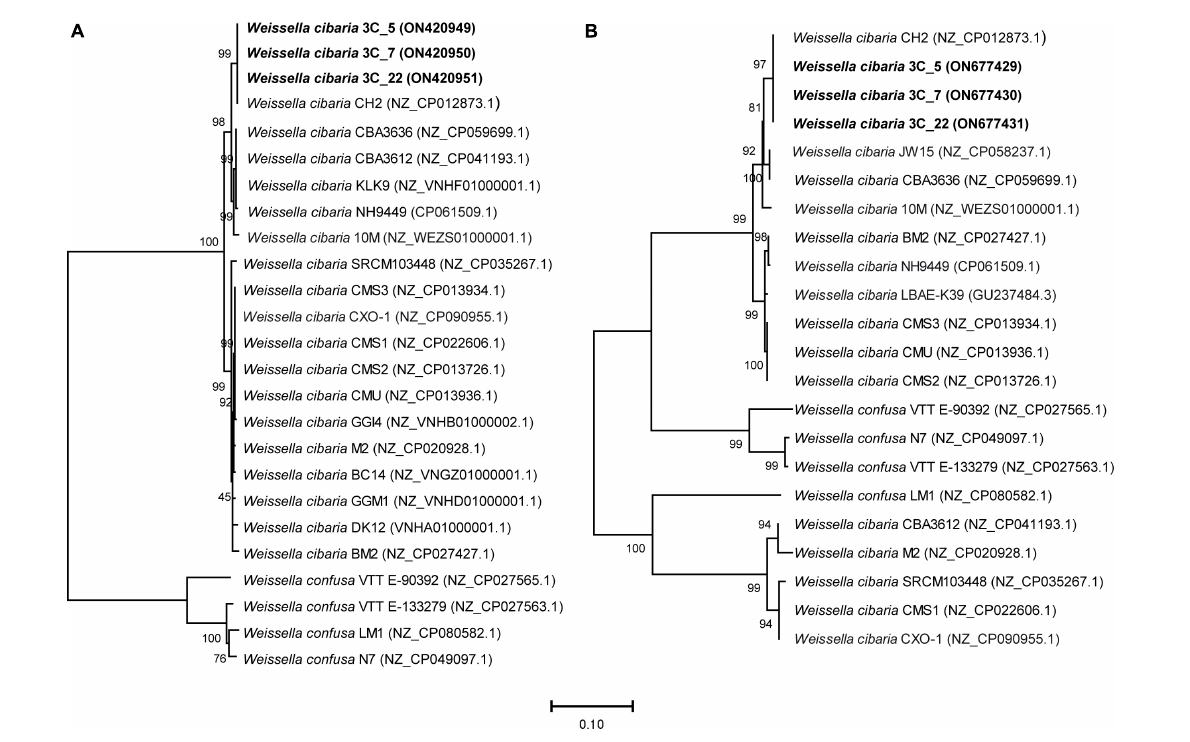
FIGURE3 Neighbor-joining phylogenetic rooted trees based on the sequences of the rib operon genes [3,290 nt; panel (A) ] and of the dsr genes [4,546 nt; panel (B) ], showing the taxonomic location of the analyzed strains. The percentage of replicate trees in which the associated taxa clustered together in the bootstrap test (1,000 replicates) are shown above the branches (64). The tree is drawn to scale, with branch lengths in the same units as those of the evolutionary distances used to infer the phylogenetic tree. The evolutionary distances were computed using the Maximum Composite Likelihood method (65) and are in the units of the number of base substitutions per site. This analysis involved 25 nucleotide sequences in the case of the rib operon sequences and 22 for the dsr gene sequences. All ambiguous positions were removed for each sequence pair (pairwise deletion option). The total number of positions in the final dataset was 3,650 and 4,584 position for the rib operon and dsr analysis, respectively. Accession numbers from GenBank are given in